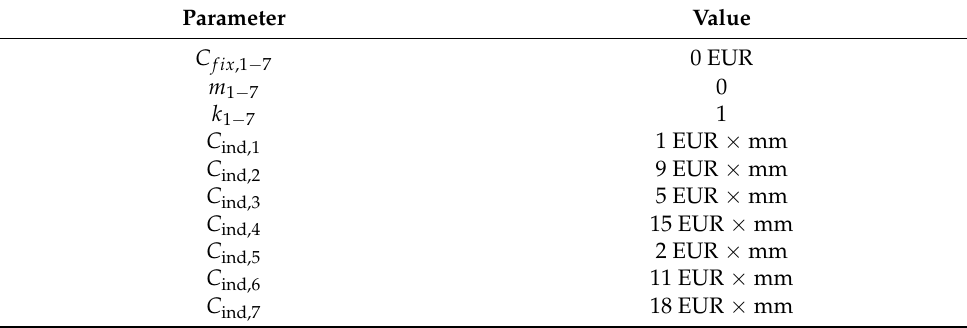
Table 6. Parameters of tolerance-cost